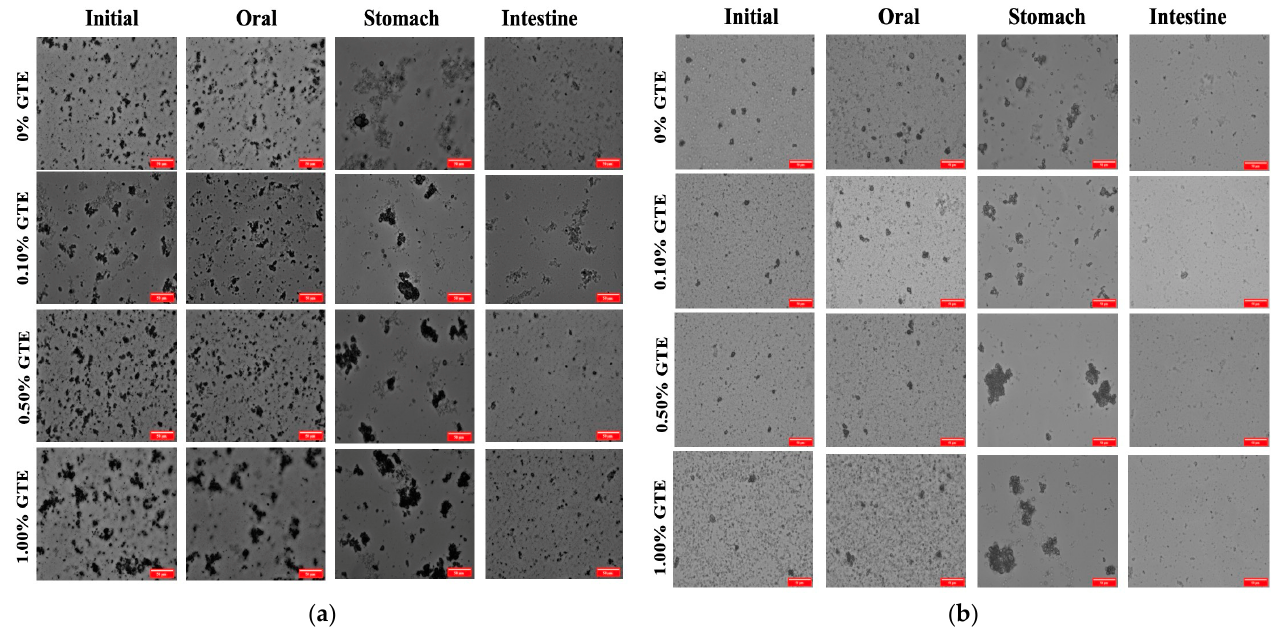
Figure 3. The optical microscope images of oat milk tea model systems after exposure to di ff erent in vitro digestive stages (scale label = 50 µm): ( a ) 1.5% fat oat milk tea model system and ( b ) 3.0% fat in vitro digestive stages (scale label = 50 µ m): ( a ) 1.5% fat oat milk tea model system and ( b ) 3.0% fat oat milk tea model system. oat milk tea model